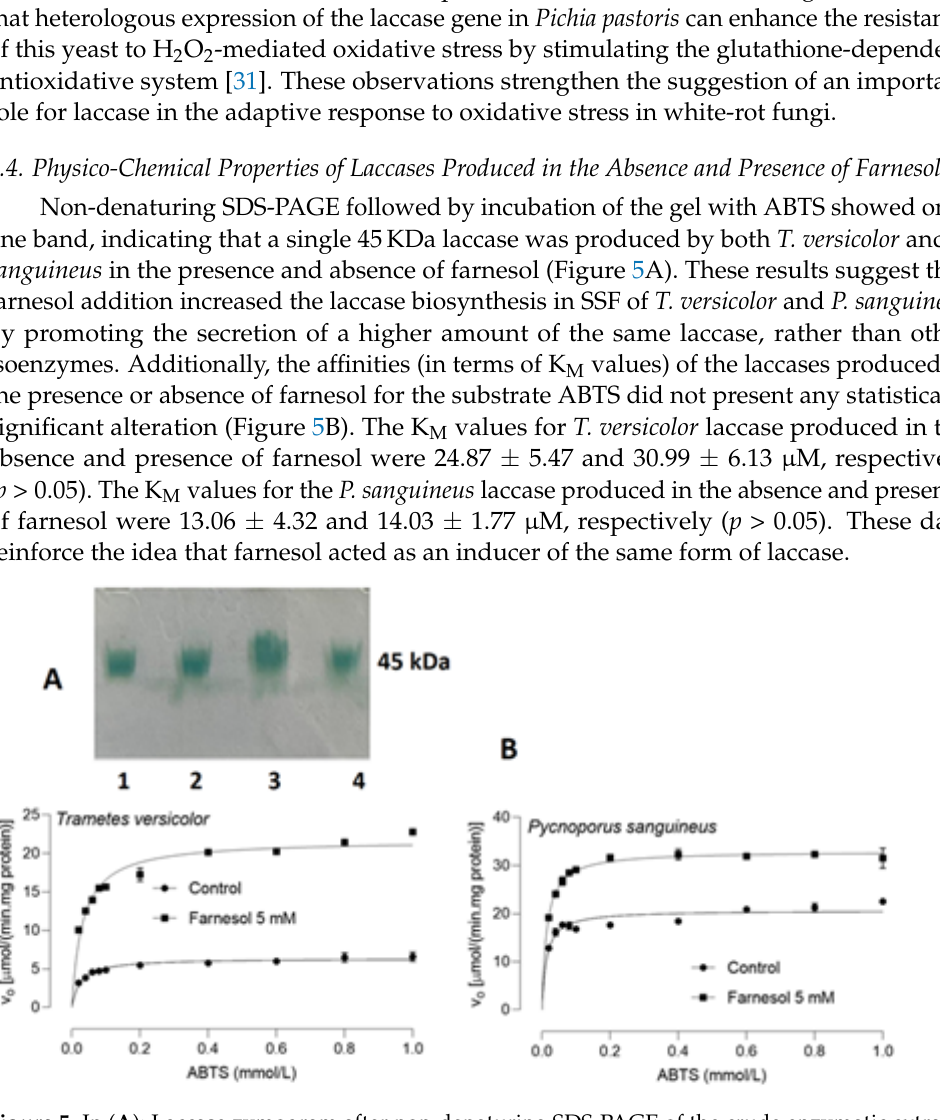
Figure 5. In ( A ): Laccase zymogram after non-denaturing SDS-PAGE of the crude enzymatic extracts. Line 1: T. versicolor laccase obtained without farnesol; Line 2: T. versicolor laccase obtained with 5 mM of farnesol; Line 3: P. sanguineus laccase obtained without farnesol; Line 4: P. sanguineus laccase obtained with 5 mM of farnesol. In ( B ): Effect of ABTS concentration on the initial velocity of the laccase obtained from T. versicolor and P. sanguineus in the presence or absence (control) of farnesol.